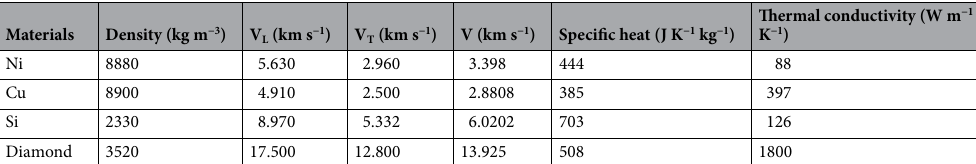
Table 3. Relevant characteristic parameters of various materials used to calculate interfacial thermal